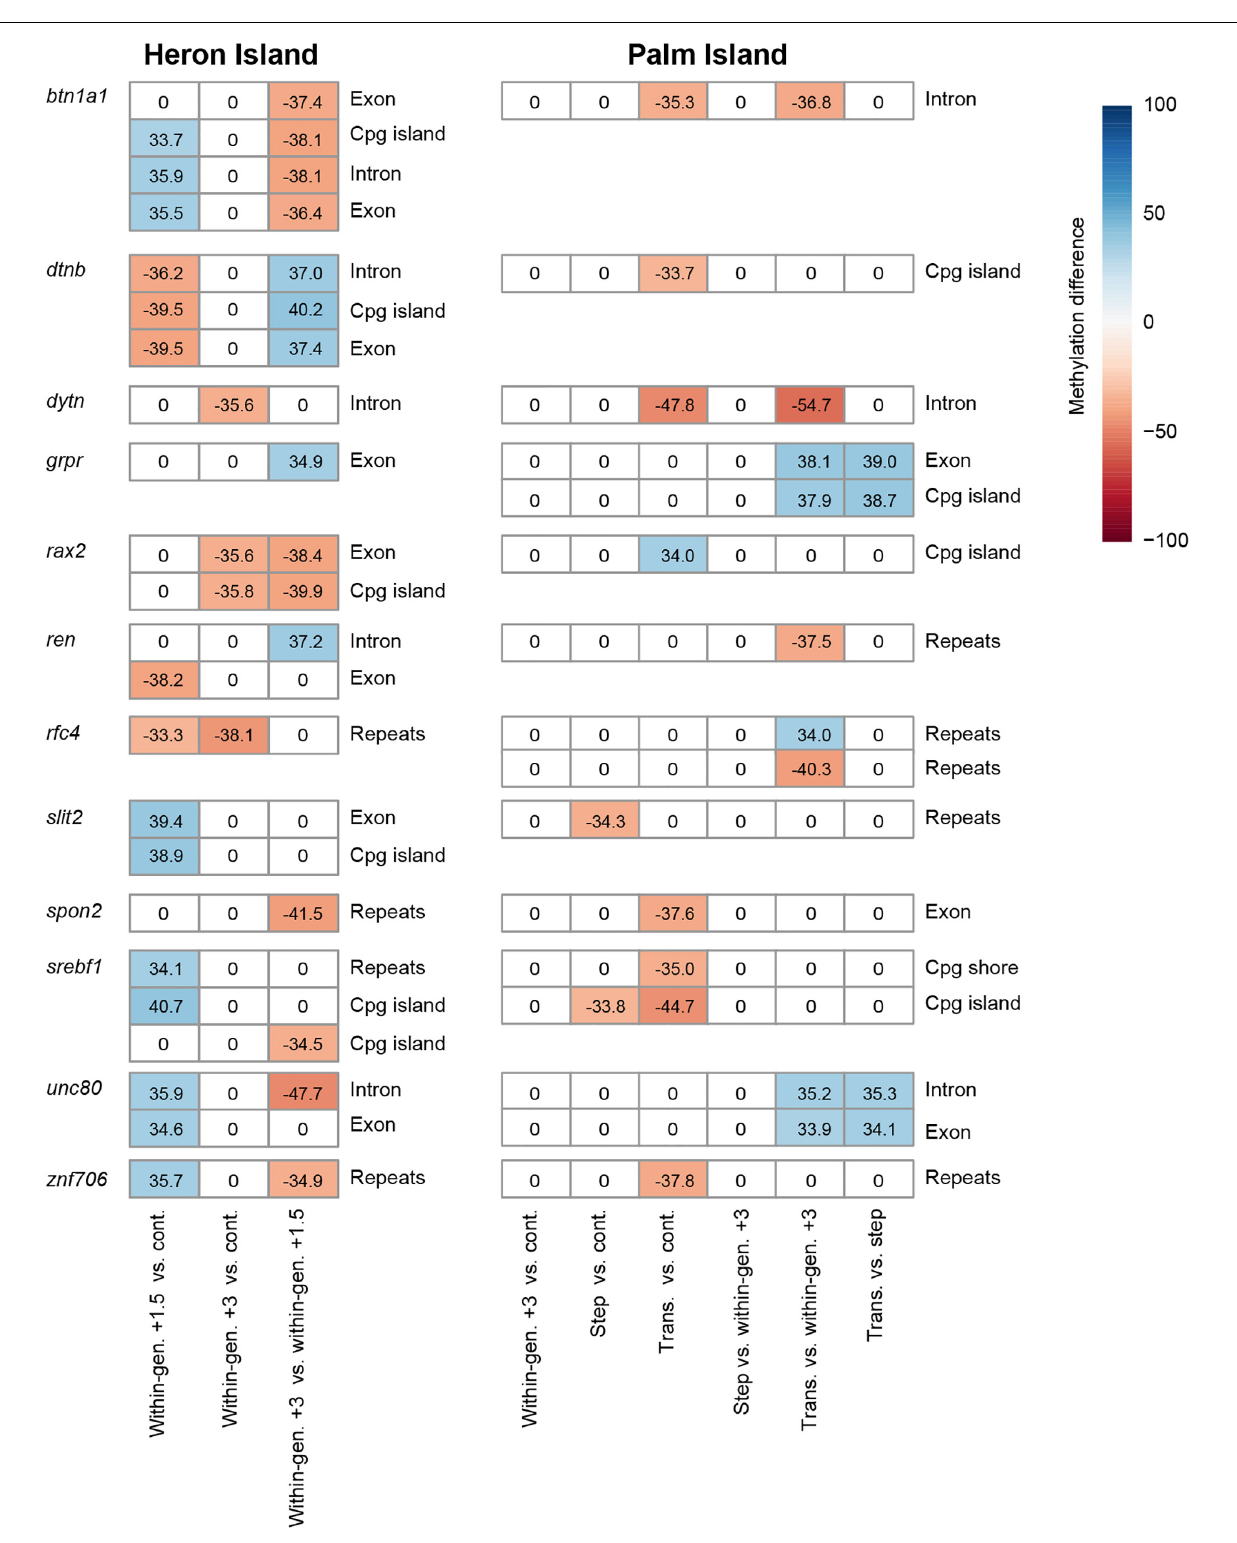
Frontiers in Marine Science |